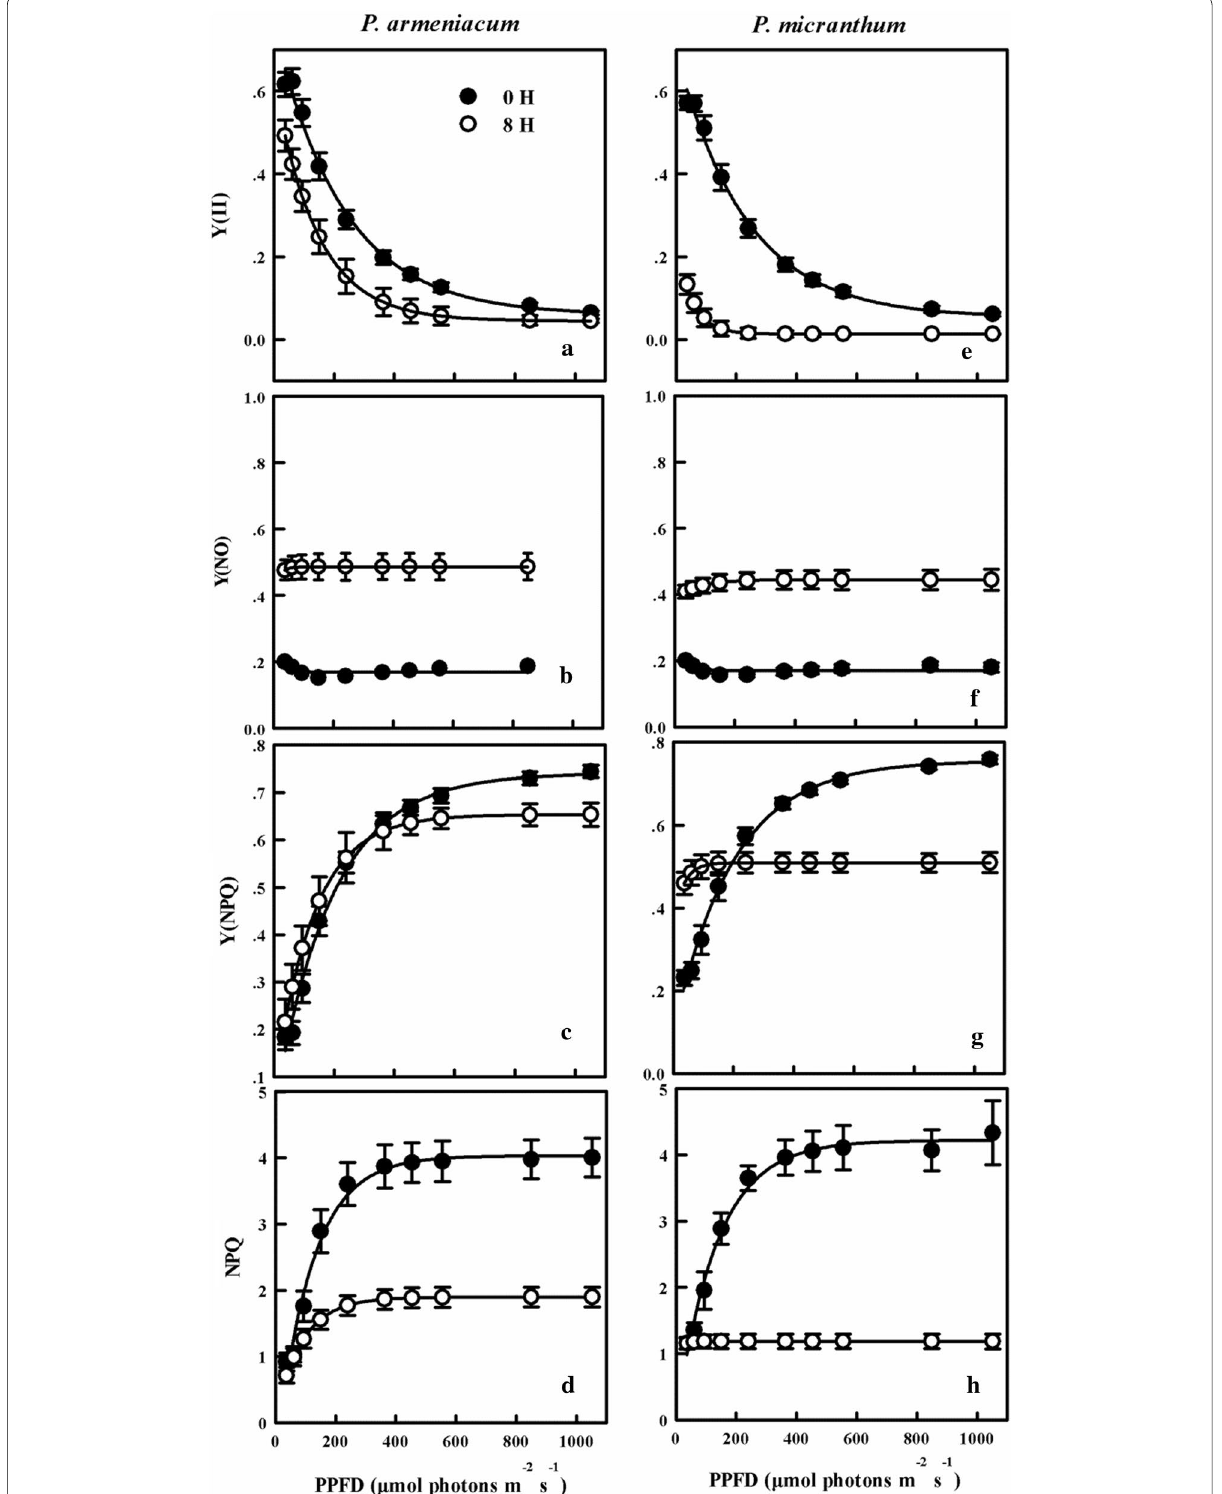
Fig. 6 Light response curves for Y(II) ( a , e ); Y(NO) ( b , f ); Y(NPQ) ( c , g ) and NPQ ( d , h ) from three species of Paphiopedilum after 8 h chilling stress. Mean SE was calculated from six independent plants per ±